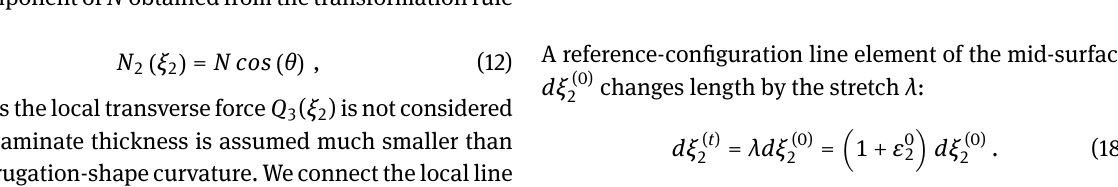
( ξ ) is not considered 3 2